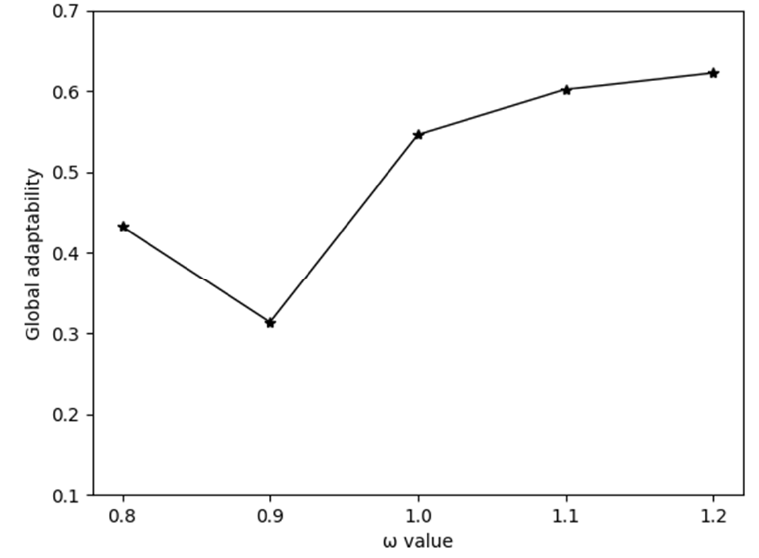
Figure 12. Effect of inertia weights on model performance.